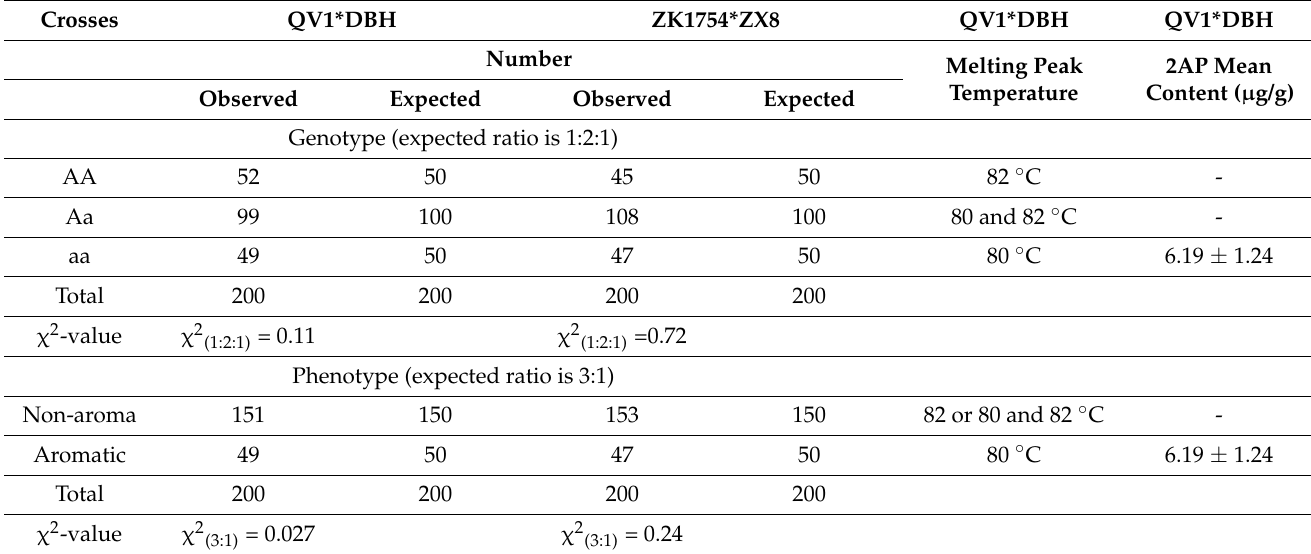
Table 1. Genetic analysis and phenotypes of the aroma trait in F 2 progeny.